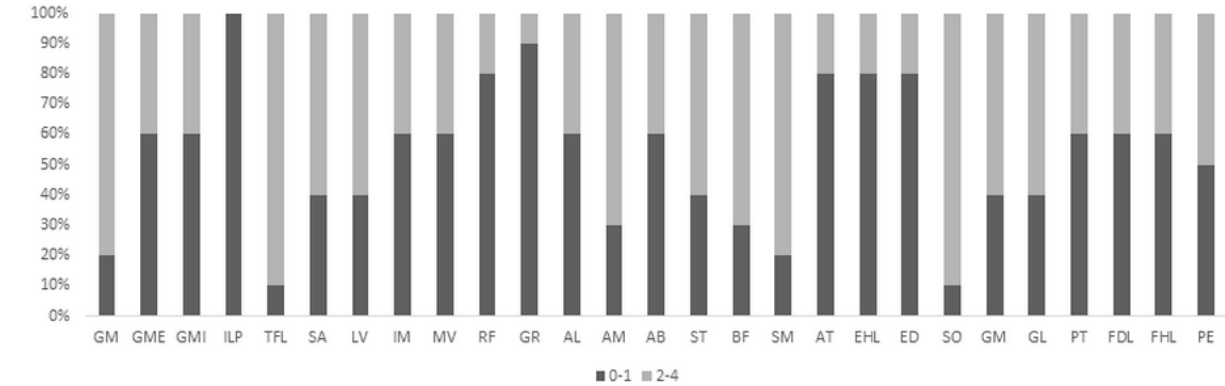
Figure 2. Pelvic and lower limb muscle involvement in ATTRv patients. Black bars indicate affected muscles with score 0–1; grey bars indicate affected muscles with score 2–4. GM gluteus maximus, GME gluteus medius, GMI gluteus minimus, ILP iliopsoas, TFL tensor fascia latae, SA sartorius, LV lateral vastus, IM intermedius vastus, MV medial vastus, RF rectus femoris, GR gracilis, AL adductor longus, AM adductor magnus, AB adductor brevis, ST semitendinosus, BF biceps femoris, SM semimembranosus, AT anterior tibialis, EHL extensor hallucis longus, ED extensor digitorum, SO soleus, GM gastrocnemius medial, GL gastrocnemius lateral, PT posterior tibialis, FDL flexor digitorum longus, FHL flexor hallucis longus, PE peroneus.